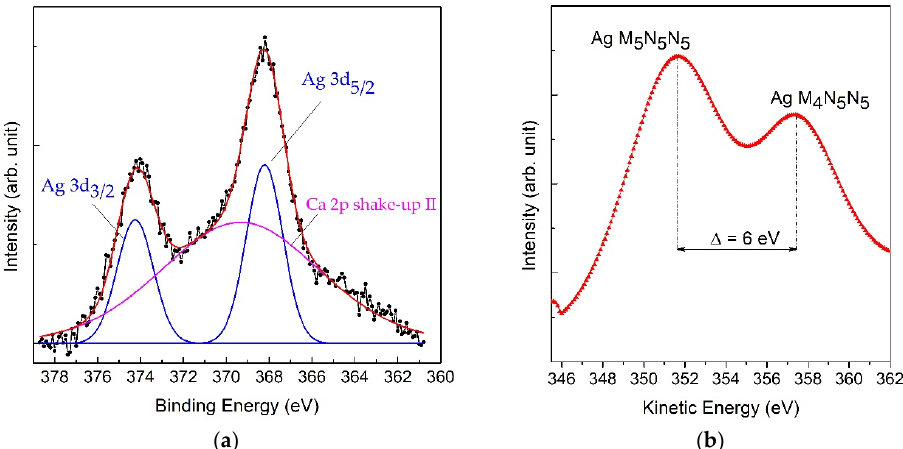
Figure 6. XPS regions of Ag 3d photoemission ( a ) and Ag MNN Auger transition ( b ) for the sample reduced with NaBH 4 (Sample 8 reported in Table 3).